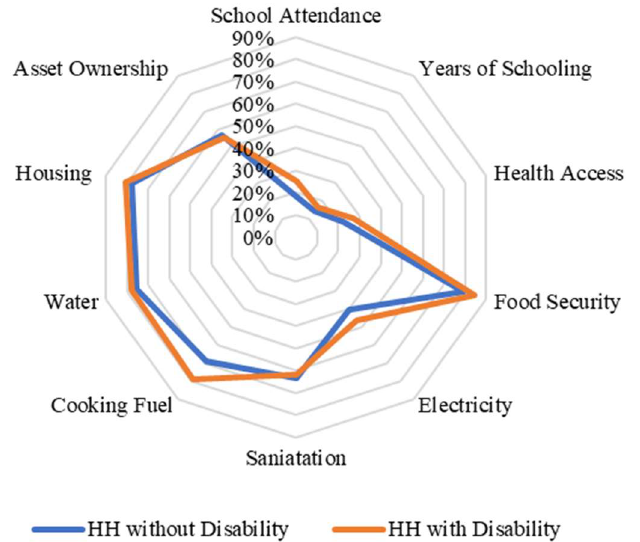
Figure 4. Censored headcount ratios for households with and without members with disability in the lowest quintile in Nigeria.